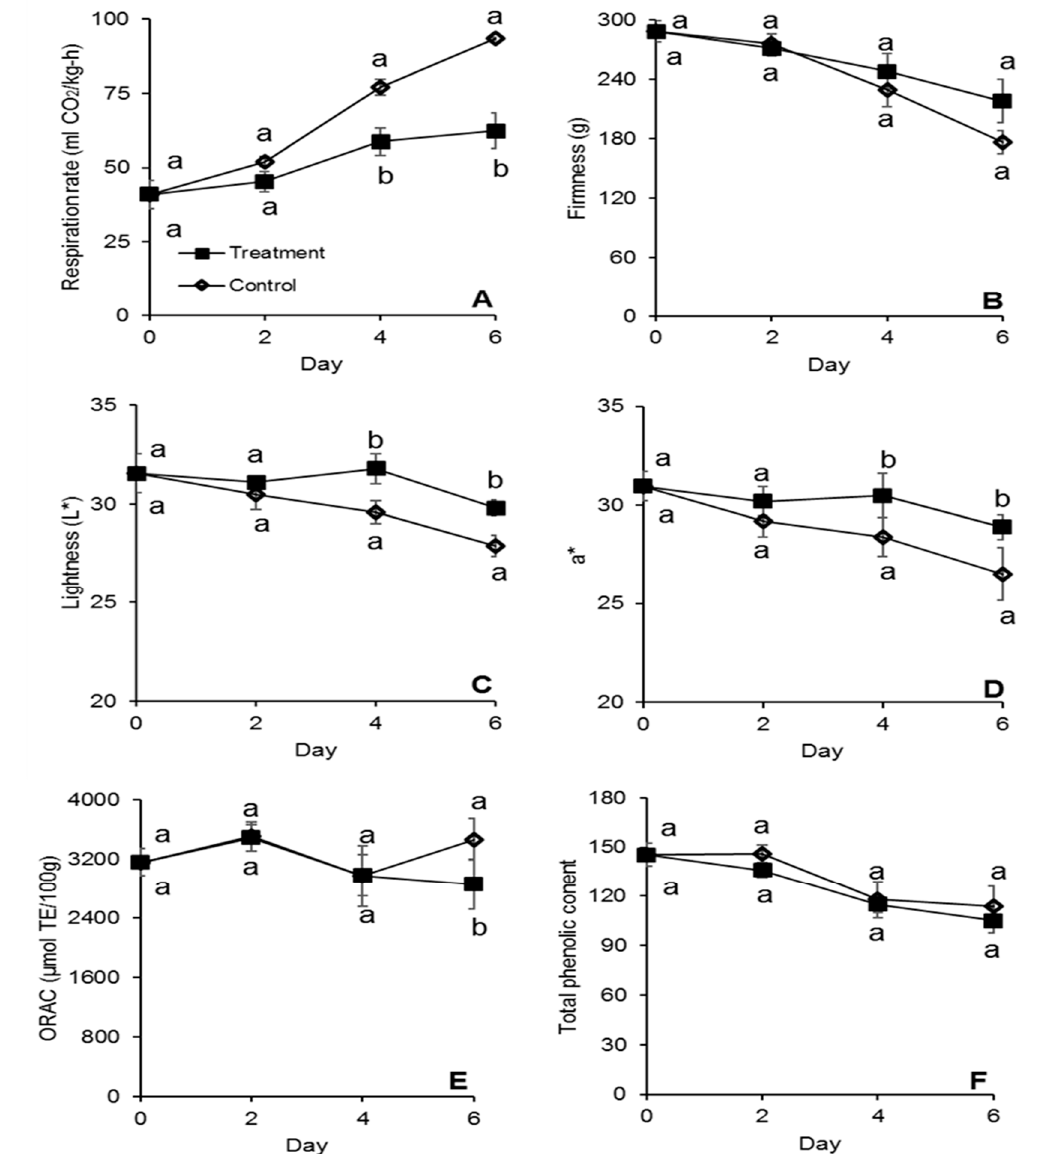
Figure 4. Respiration rate ( A ), fruit firmness ( B ), fruit surface color measured as lightness (L*) ( C ) and a* value ( D ), antioxidant capacity ( E ) and total phenolic content ( F ) of strawberries stored at 12 °C for 6 days in molded fiber baskets containing pullulan packaging films loaded with 1% w/w cinnamaldehyde SLN (treatment) or without (control). Different letters (a, b) for each day denotes a significant difference ( p < 0.05) between the treatment and the control. The error bars represent standard error.